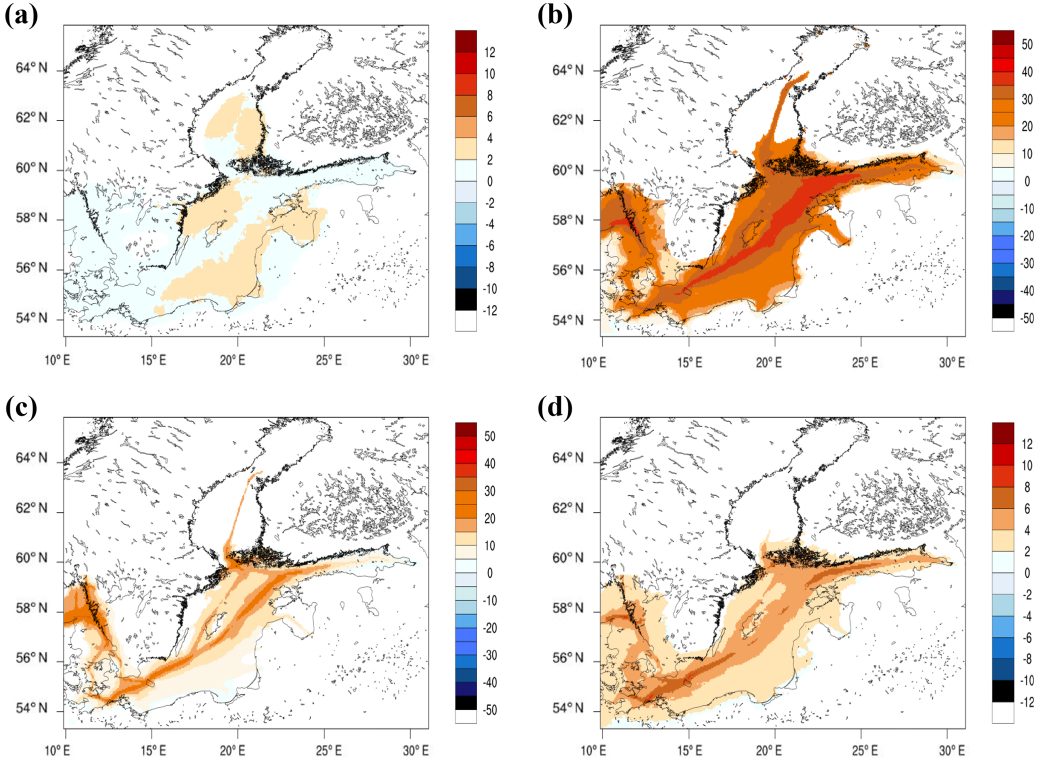
Figure 10. Effect of lower fuel efficiency on the future air quality in summer (JJA) 2040 in the Baltic Sea region as relative difference (in percent) between the scenario simulations EEDI 2040 and BAU 2040: (a) daily maximum O 3 , (b) NO 2 , (c) SO 2 and (d) PM 2 . 5 . Not coloured (white) areas indicate grid cells with ship contribution in BAU 2040 of less than 1.0ppbv, 0.1ppbv, 0.01ppbv, 0.005µgm − 3 , for daily max O 3 , NO 2 , SO 2 and PM 2 . 5 ,